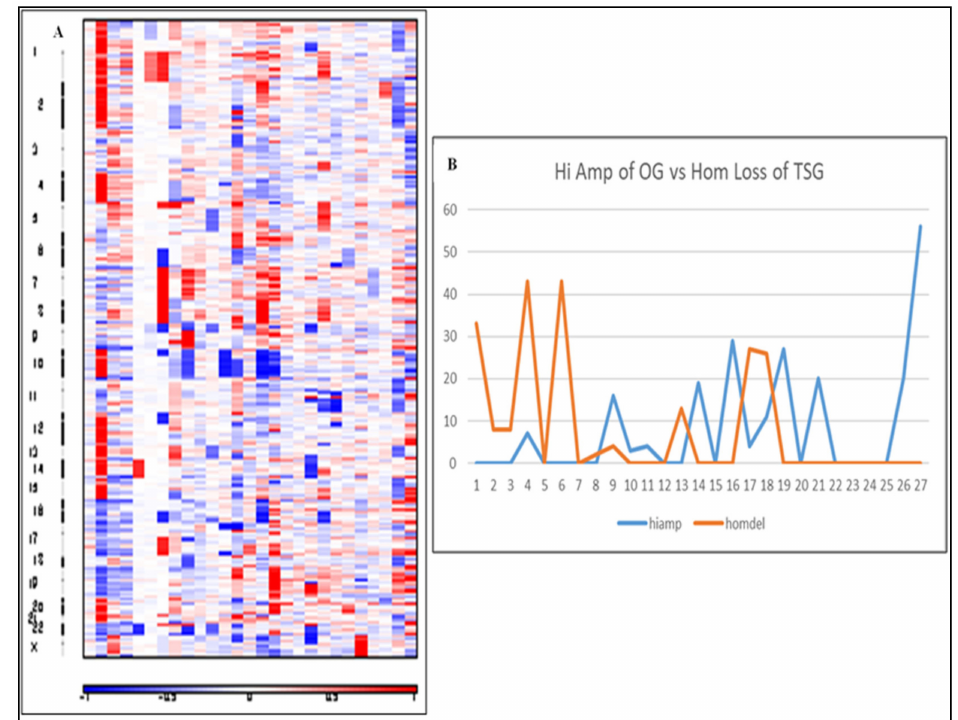
Figure 4. Copy number alteration (CNA) analysis of the 27 rare-cancer cases using GISTIC2 with input from Sequenza. ( A ). Heat map showing amplified (red) and deleted (blue) regions along the chromosomes. Cases are aligned on the x -axis and chromosomes on the y -axis. ( B ). Frequency of highly amplified oncogenes (blue) and tumor suppressor genes with putative homozygous deletions (orange) in each